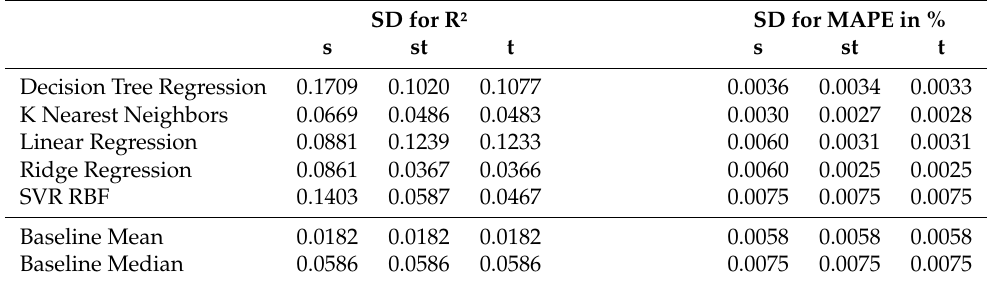
Table A6. Stacking Box Data Set II: standard deviations for the results of Target Distance B. SD for R² SD for MAPE in